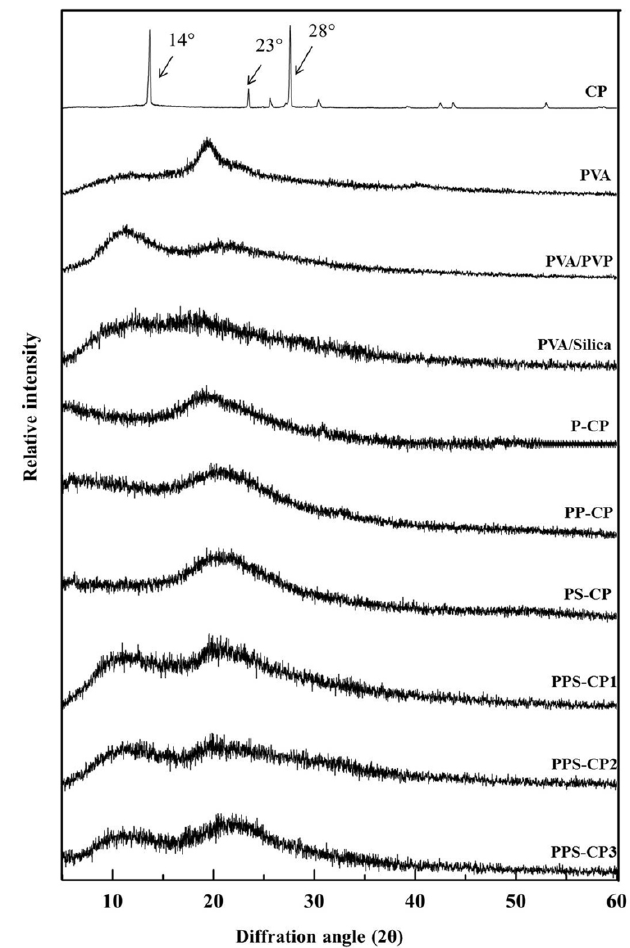
Figure 3. XRD patterns of CP-ENFs and pure excipients in EFASs in comparison with intact crystalline CP.